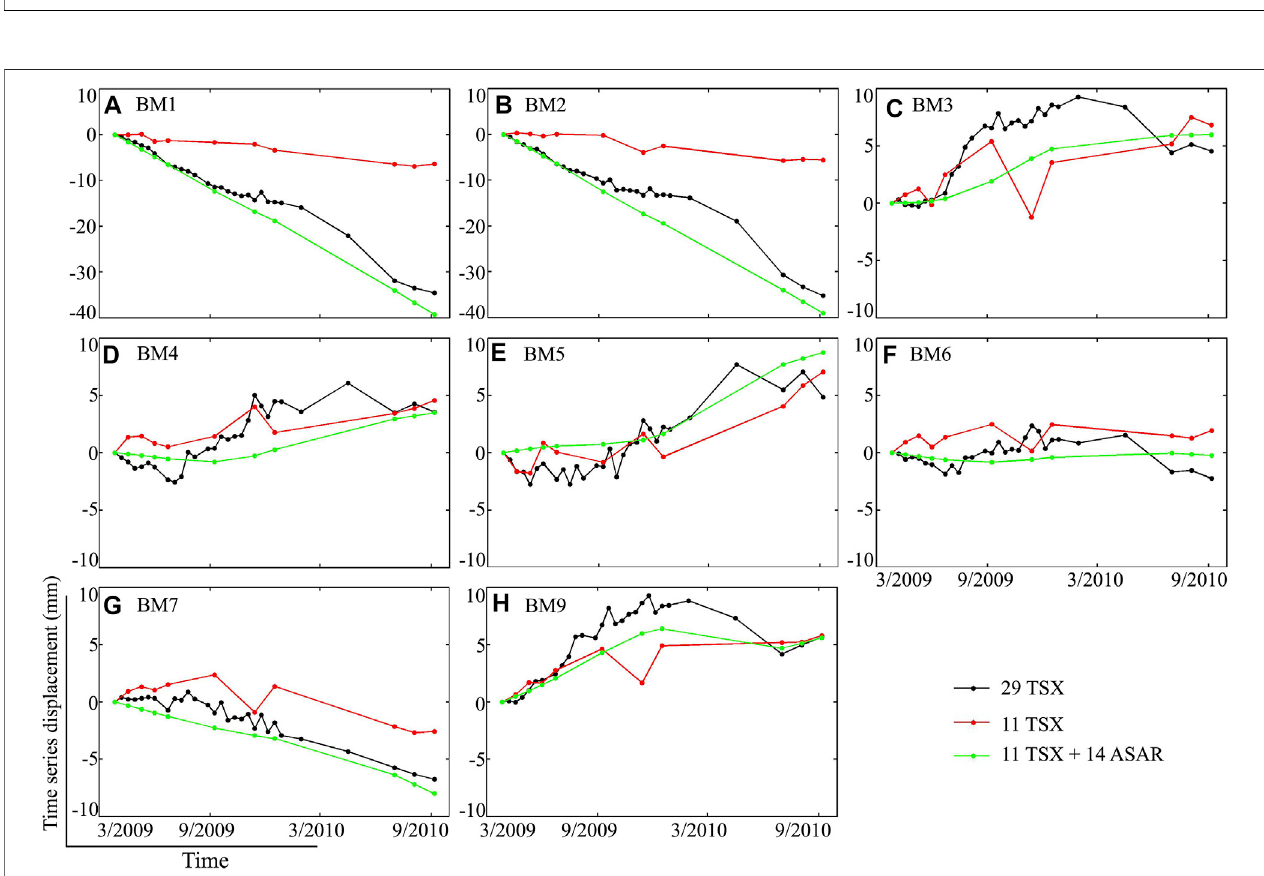
FIGURE 9 | Time series of displacement at (A – G) BM1 ~ BM7 and (H) BM9 derived from three sets of SAR datasets, that is, the 29 TSX acquisitions only, the 11 TSX acquisitions only, and the combination of 11 TSX and 14 ASAR acquisitions. It should be noted that the time series of displacement is relative to BM8.